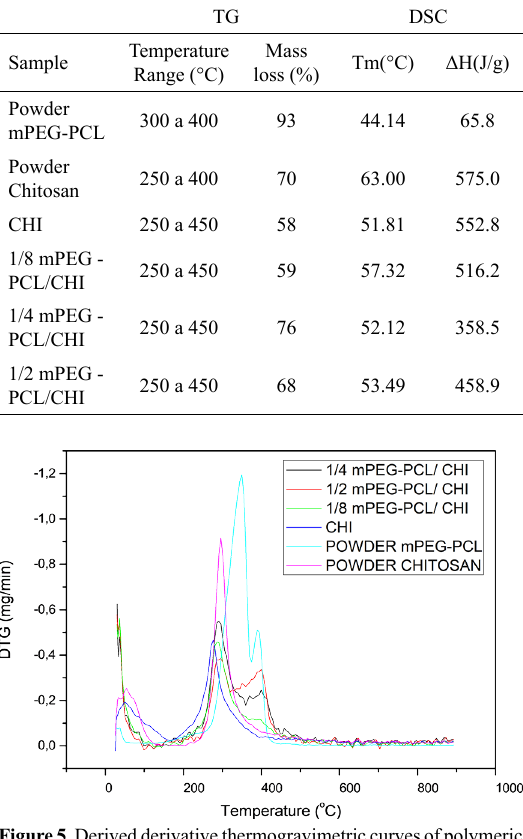
Table 5. Results of thermal analyses of raw materials and membranes unloaded with gentamicin: thermogravimetric and calorimetric parameters.